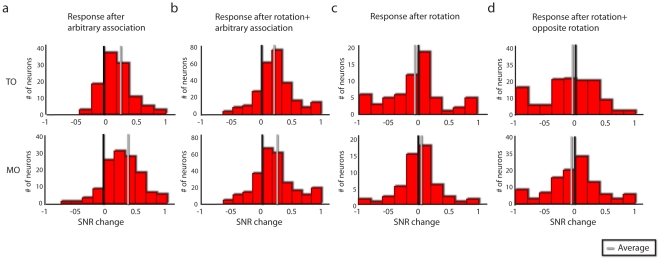
Additional analysis of color sensitivity.Change in the SNR for different target colors during the TO epoch (upper panel) and MO (lower panel), where positive values indicate an increase in SNR after learning: (a) an arbitrary association task alone; (b) arbitrary association following rotation; (c) rotation alone or (d) rotation followed by the opposite rotation. Grey lines indicate the mean of the post-learning distribution, black lines represent zero change. Note that learning an arbitrary association, but not a rotation, resulted in increased SNR.